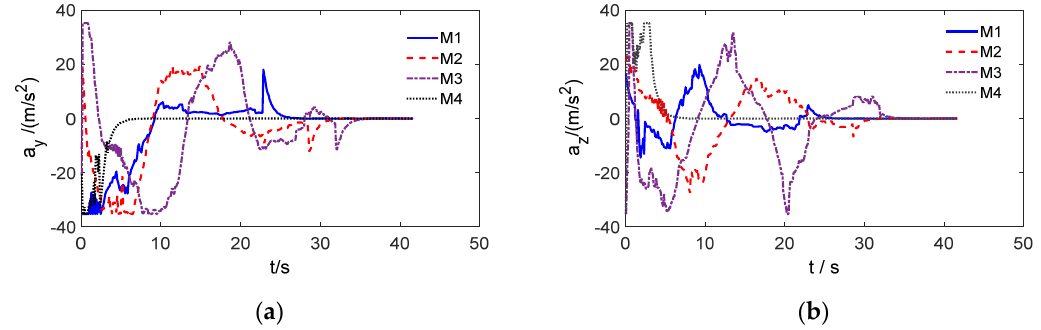
Figure 20. Normal acceleration curves obtained by the MPC guidance algorithm: ( a ) Normal acceleration curve of the dive plane; ( b ) Normal acceleration curve of turning plane.